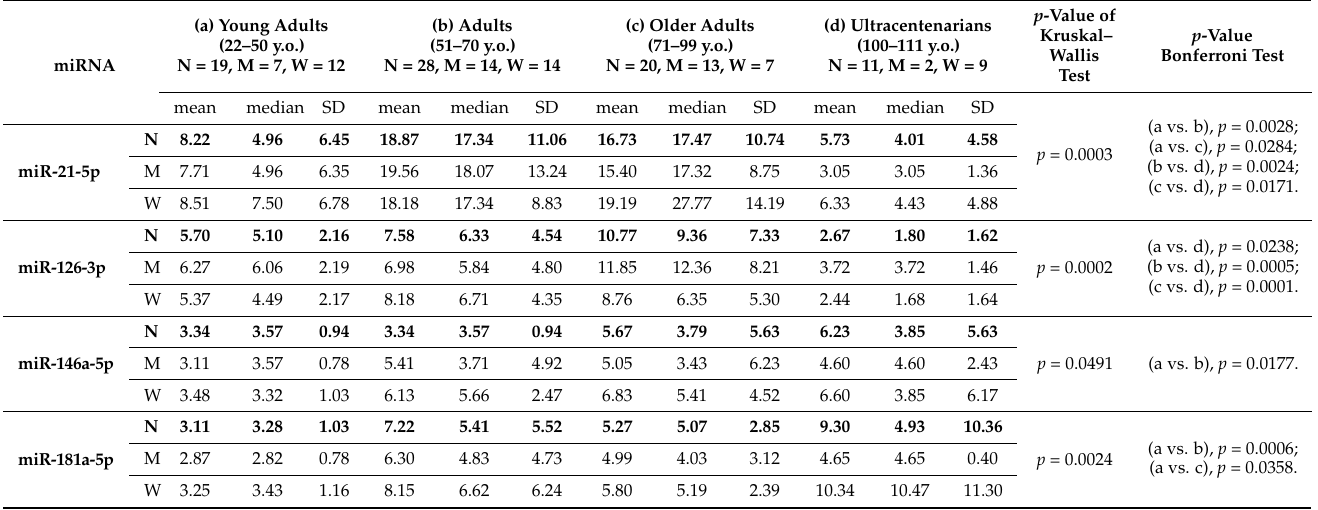
Table 1. Plasma miRNA levels in the 4 age-groups of Sicilian population. Please, note that a, b, c, and d are the letters used to indicate the different groups: a = Young Adults; b = Adults; c = Older Adults; d = Ultracentenarians.